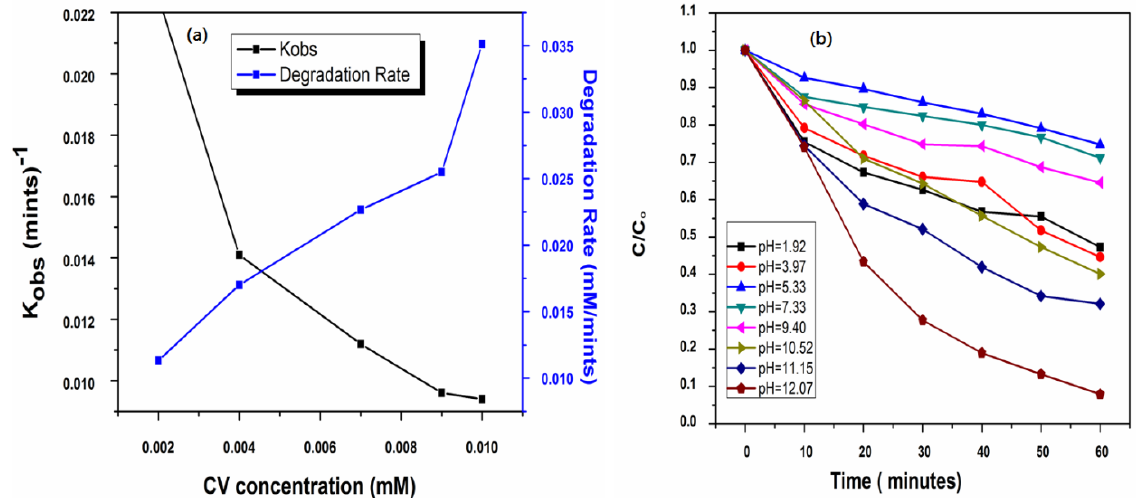
Figure 2. Effect of initial ( a ) concentration of CV on its K obs (mint) − 1 and removal rate (mM mint) − 1 by UV/PMS process at [PMS] ₒ = 2.0 mM, [pH] ₒ = 5.88 ( b ) solution pH on the removal efficiency of CV by U/PMS on removal efficiency of CV by UV/PMS process at [CV] ₒ = 0.01 mM (5 ppm), [pH] ₒ = 1.92 – 12.07.